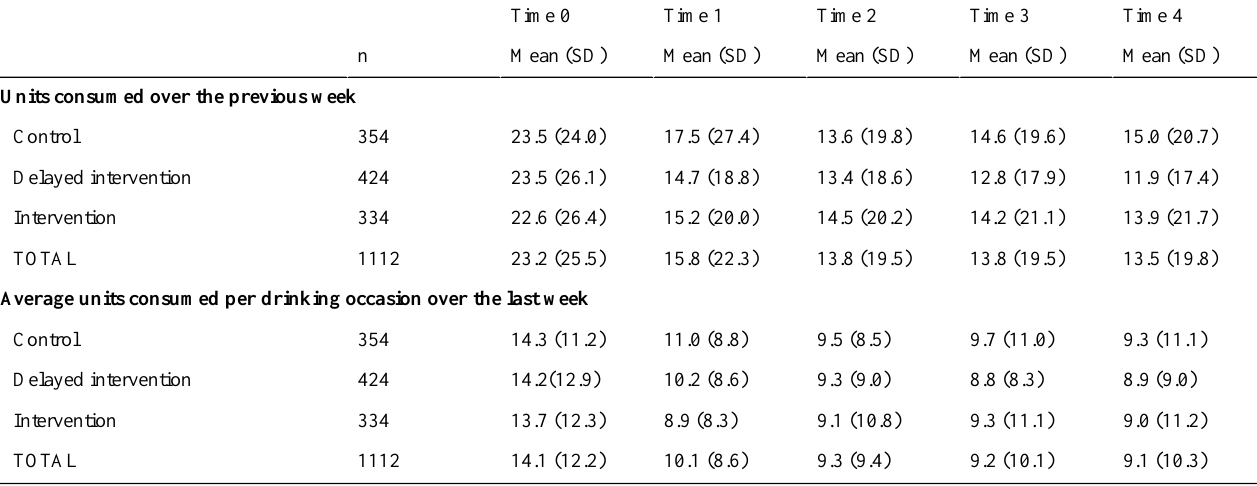
Table 2. Mean (SD) reported units consumed in the previous week by treatment arm and average per occasion over time